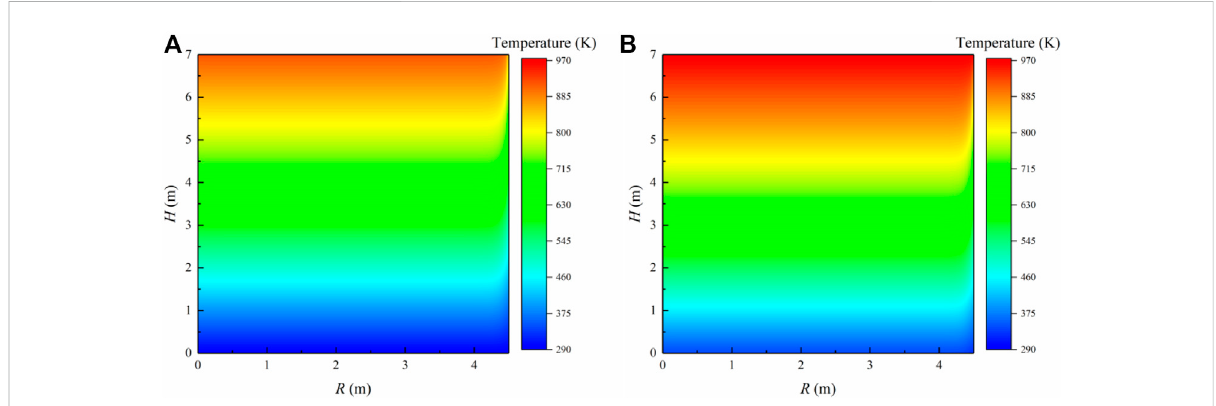
FIGURE 9 Temperature fi elds of the multi-size sinter bed with the equivalent particle diameter of 11.45 mm: (A) Gas; (B) Sinter.